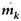
Global motion mk and the corresponding moving average m^k for a randomly selected 2h of video footage.The moving average was performed over a window of K = 90 frames. The interval of time series boxed in red on the left correspond to the video image on the right, in which the animals were in motion.